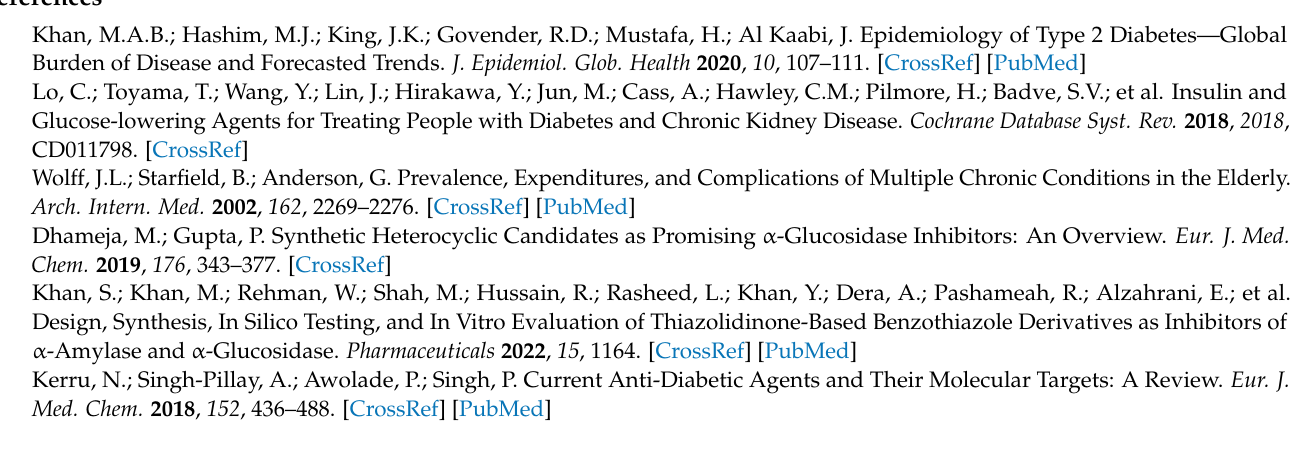
tivity; Table S2: Inhibitory activities of 1,3,5-trisubstituted-2-thioxoimidazolidin-4-ones derivatives toward α -amylase activity; Table S3: In vitro cytotoxicity of compounds ( 5a and 7a ) against WI-38 cells; Table S4: Effect of Compounds ( 5a and 7a ) on scavenging DPPH free radical; Table S5: Effect of Compounds ( 5a and 7a ) on ROS